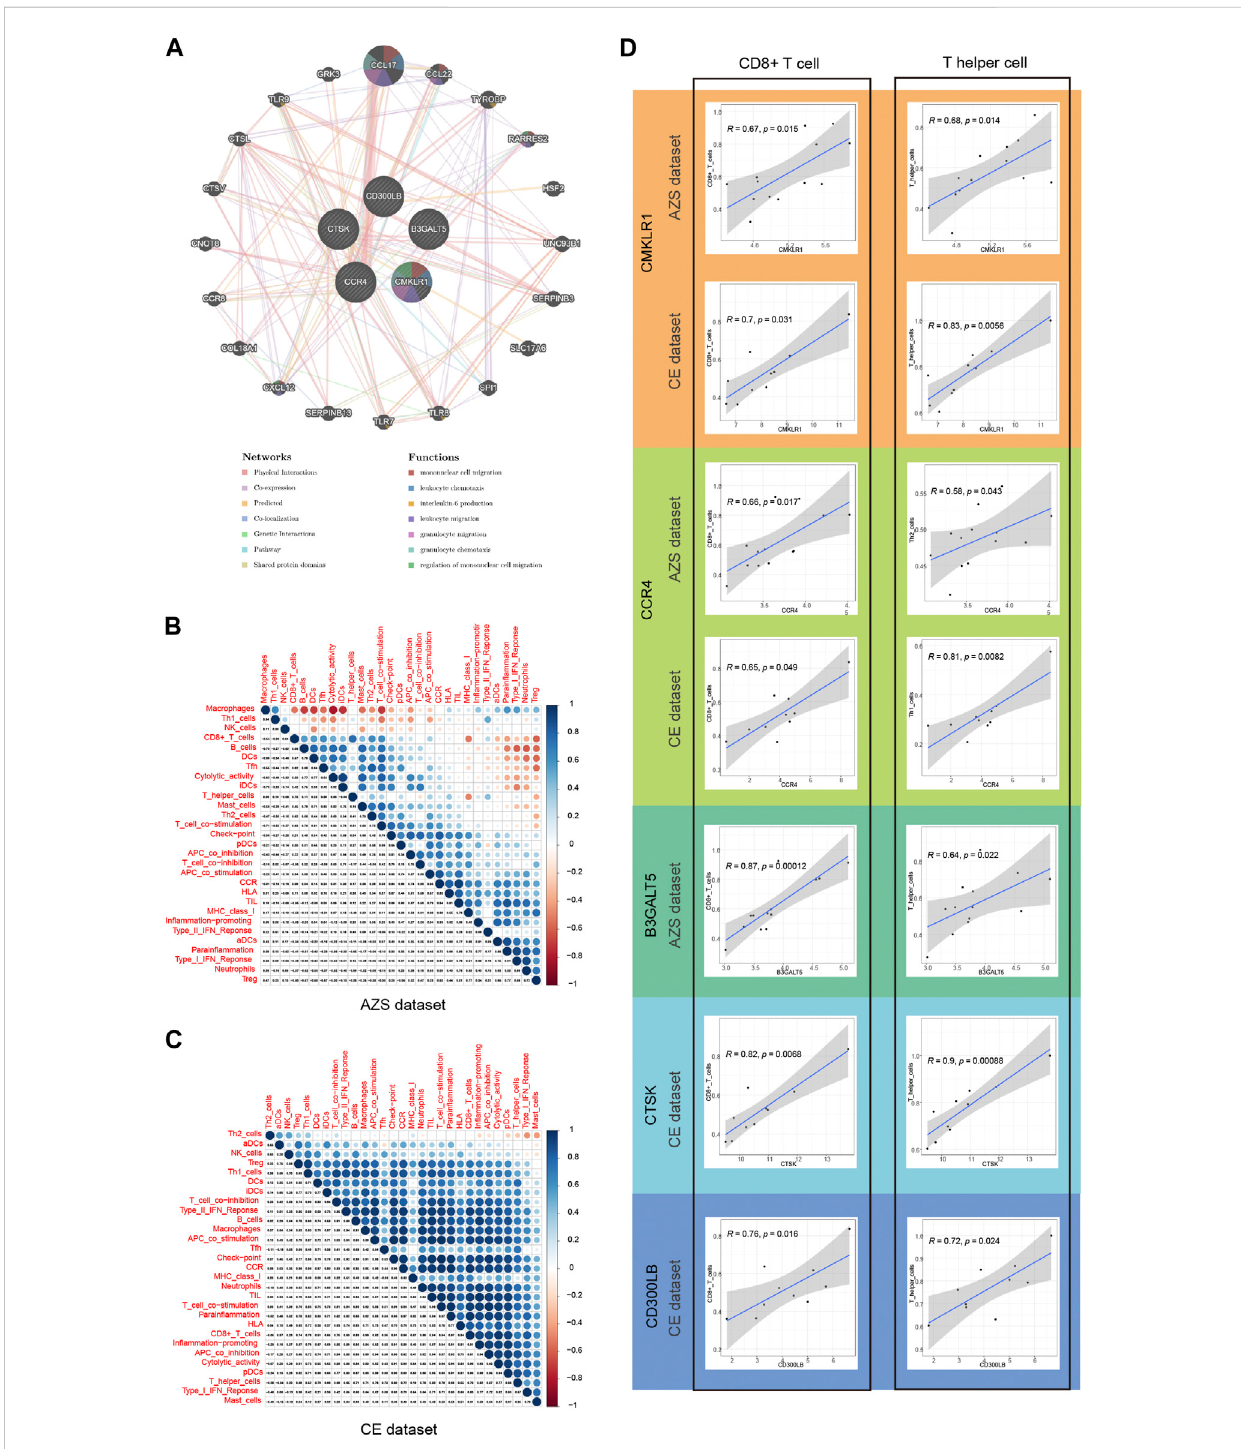
FIGURE 7 Correlation of fi ve hub genes ( CD300LB, CMKLR1, CCR4, B3GALT5, and CTSK ) with immune in fi ltration and gene-gene interaction. (A) Gene – gene interaction network for fi ve hub genes based on the GeneMANIA database. (B) Correlation results of immune cell/function in AZS samples, and the spearman correlation coef fi cient is represented by the dot diameter and color bar. (C) Correlation results of immune cell/function in CE samples. (D) Correlation results between fi ve hub genes and two main immune cell types (CD8 + T cell and T helper cell). AZS: asthenozoospermia; CE: chronic epididymitis; ssGSEA: single-sample gene set enrichment